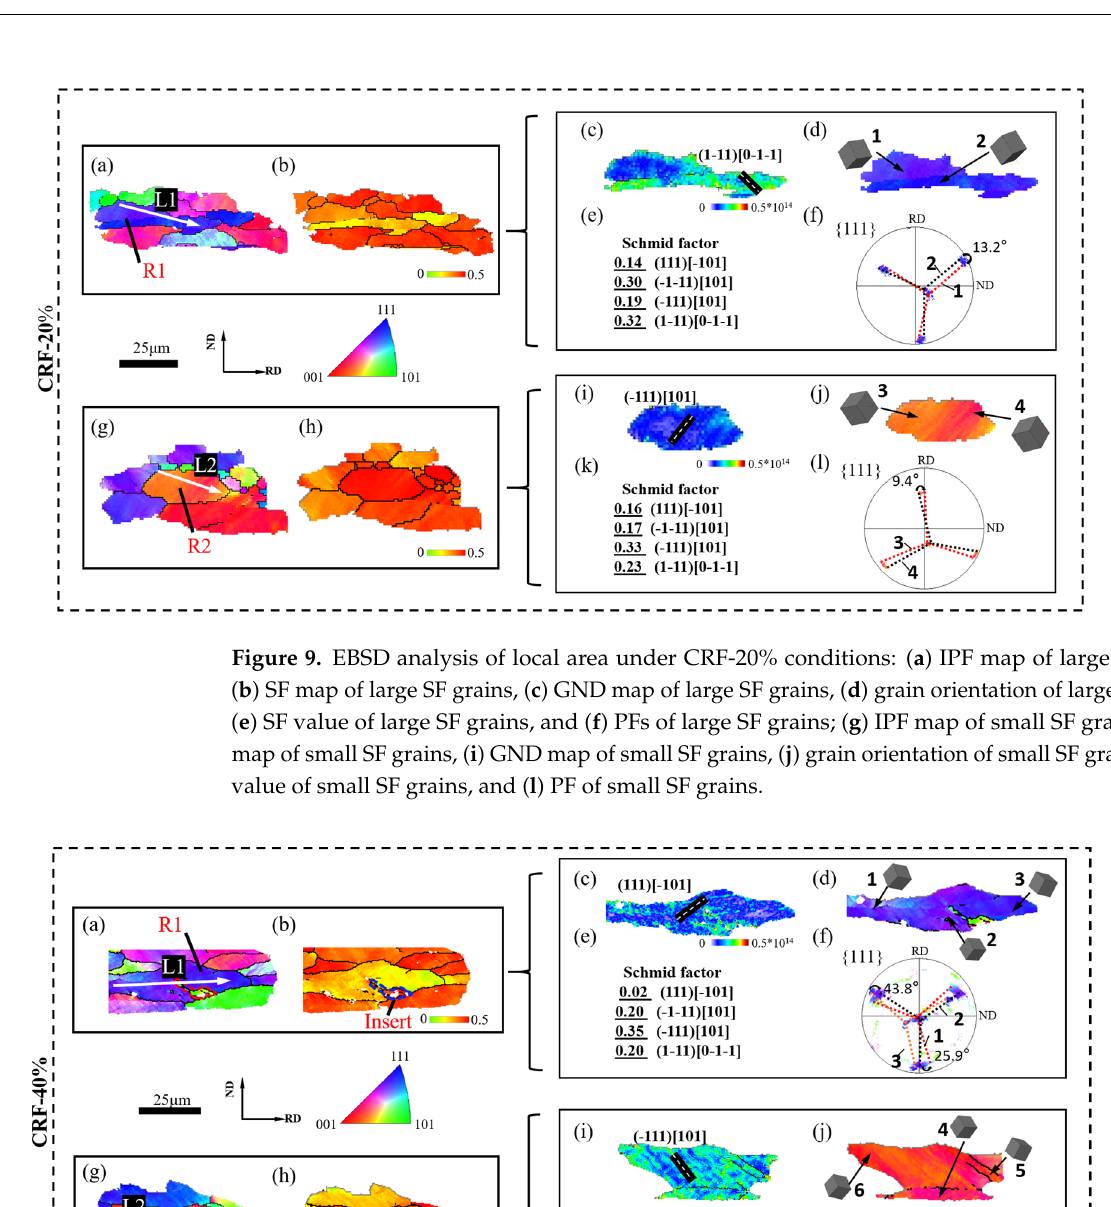
Figure 8. EBSD analysis of local area under as-annealed conditions: ( a ) IPF map of large SF grains, ( b ) SF map of large SF grains, ( c ) GND map of large SF grains, ( d ) grain orientation of large SF grains, ( e ) SF value of large SF grains, and ( f ) PFs of large SF grains; ( g ) IPF map of small SF grains, ( h ) SF map of small SF grains, ( i ) GND map of small SF grains, ( j ) grain orientation of small SF grains, ( k ) SF value of small SF grains, and ( l ) PF of small SF grains.